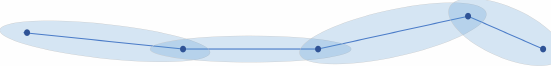
Figure 7. A “straight” line with narrow ellipses.